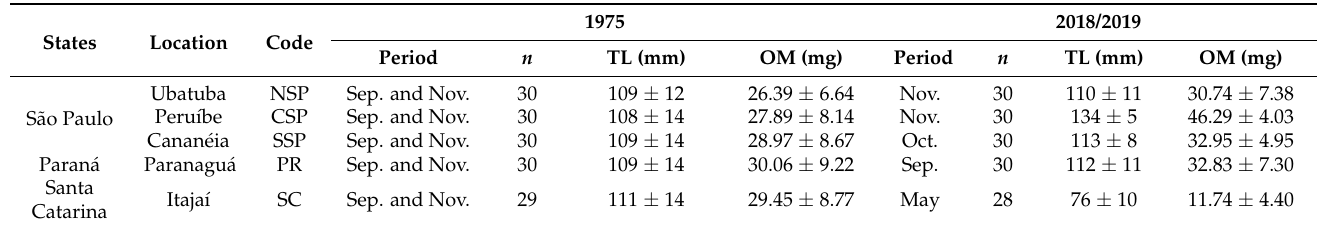
Table 1. States, locations, and their respective code, period of capture, sample size ( n ), total length (TL, mm) and otolith mass (OM, mg) of Isopisthus parvipinnis used in this study. For TL and OM, mean and standard deviation are presented. Legend: North of S ã o Paulo (NSP), Center of S ã o Paulo (CSP), South of S ã o Paulo (SSP), Paran á (PR), Santa Catarina (SC). States